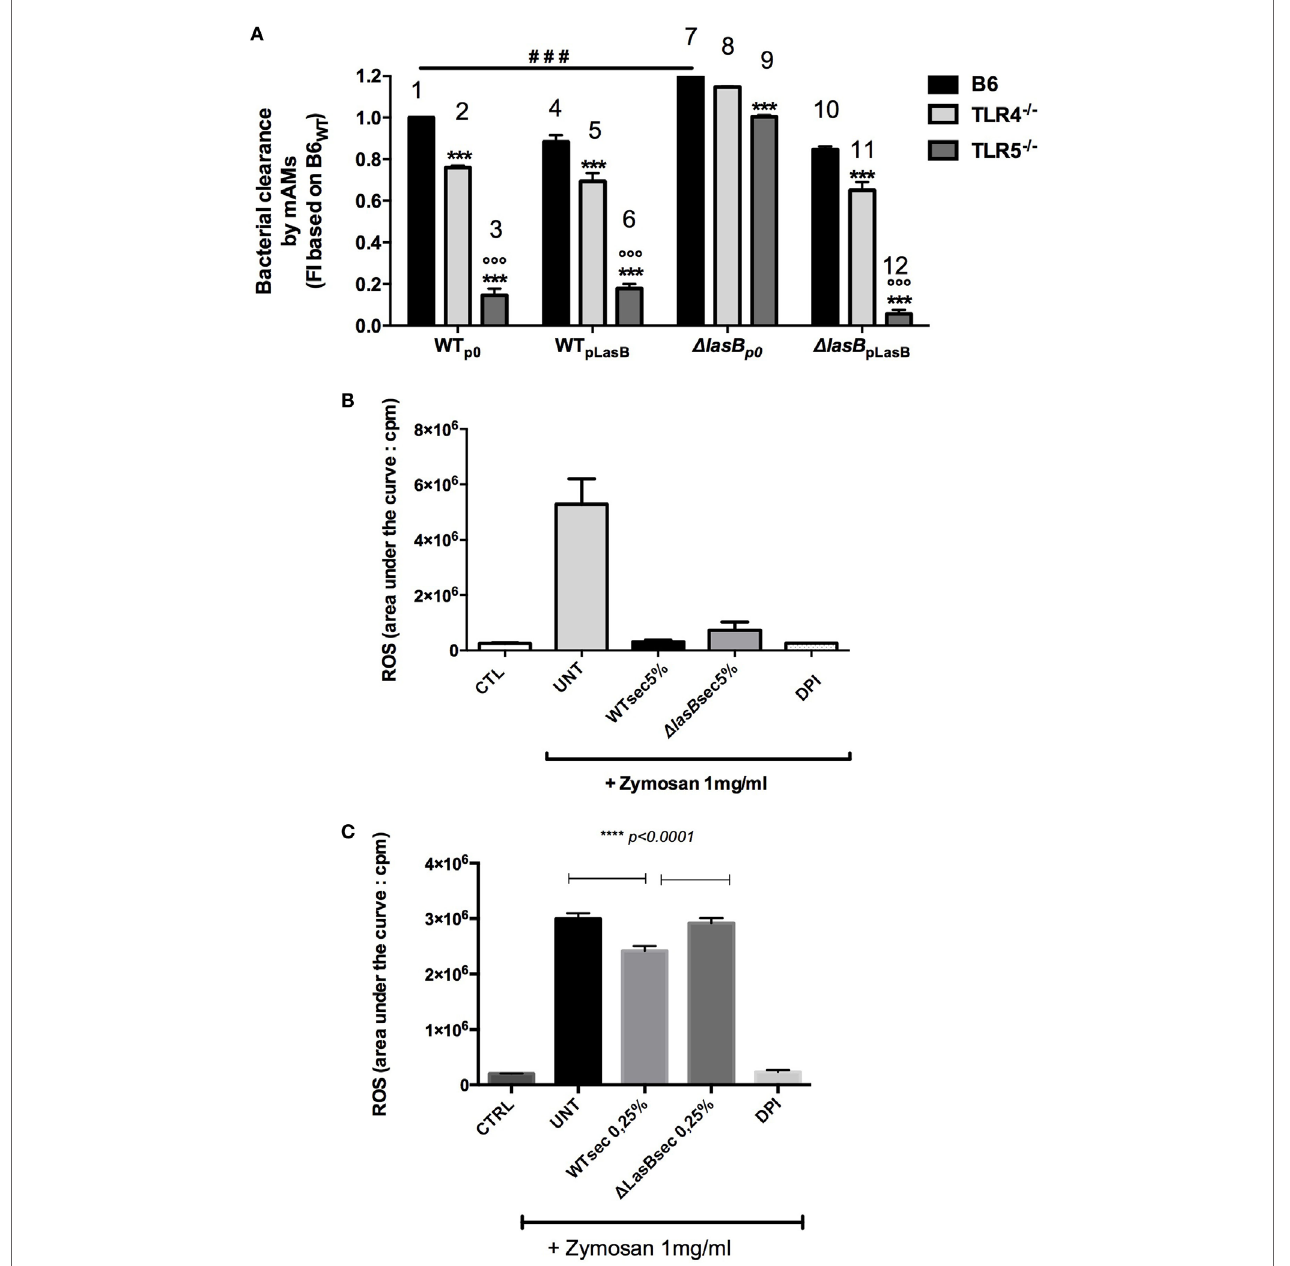
FigUre 5 | Role of TLR-5 in bacterial clearance and modulation of reactive oxygen species (ROS) production by PAO1 secretomes. (a) Pooled primary lung alveolar macrophages (AMs) from WT C57Bl/6JRj ( n = 6), TLR-4 KO ( n = 6), TLR-5 KO ( n = 6) mice were obtained from BALs, as above. Cells (10 5 cell in 96 wells) were infected with WTp0-, WTpLasB-, Δ LasBp0-, Δ LasBpLasB-PAO1 (moi 1) for 4 h. Then, bacterial clearance was measured by pooling supernatants and cell lysates (see Figure 4 ). Results are expressed as mean ± SEM and statistical analysis performed with one-way ANOVA followed by Tukey’s test. ### p < 0.001, compared to p0-PAO1 infection of C57/Bl6 AMs; *** p < 0.001, compared to B6; ooo p < 0.001, compared to Δ LasBp0 TLR5 − / − . (B) MPI cells (7 × 10 5 cells in 5 mL tubes) were pre-incubated ( n = 4) with either medium (CTL), WTp0- or Δ LasBp0-PAO1 SECs (5%), or with diphenyleneiodonium (an inhibitor of the NADPH oxidase). After 30 min, either medium (CTRL) or opsonized zymosan (1 mg/mL) and luminol were added to the culture medium. ROS production was recorded using chemiluminescence measurements as explained in Section “Materials and Methods.” Results are expressed as mean ± SEM and statistical analysis performed with one-way ANOVA followed by Tukey’s test. CTRL v Untreated, v WT SEC 5%, v Δ LasB SEC 5%: all p < 0.05; WT SEC 5%, v Δ LasB SEC 5%: p = 0.1. (c) Independently (